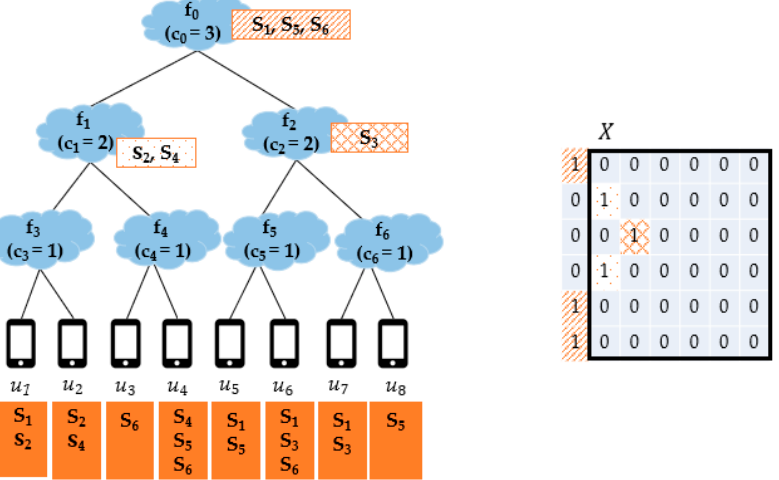
Figure 3. The service provisioning result of the MC-SP mechanism.